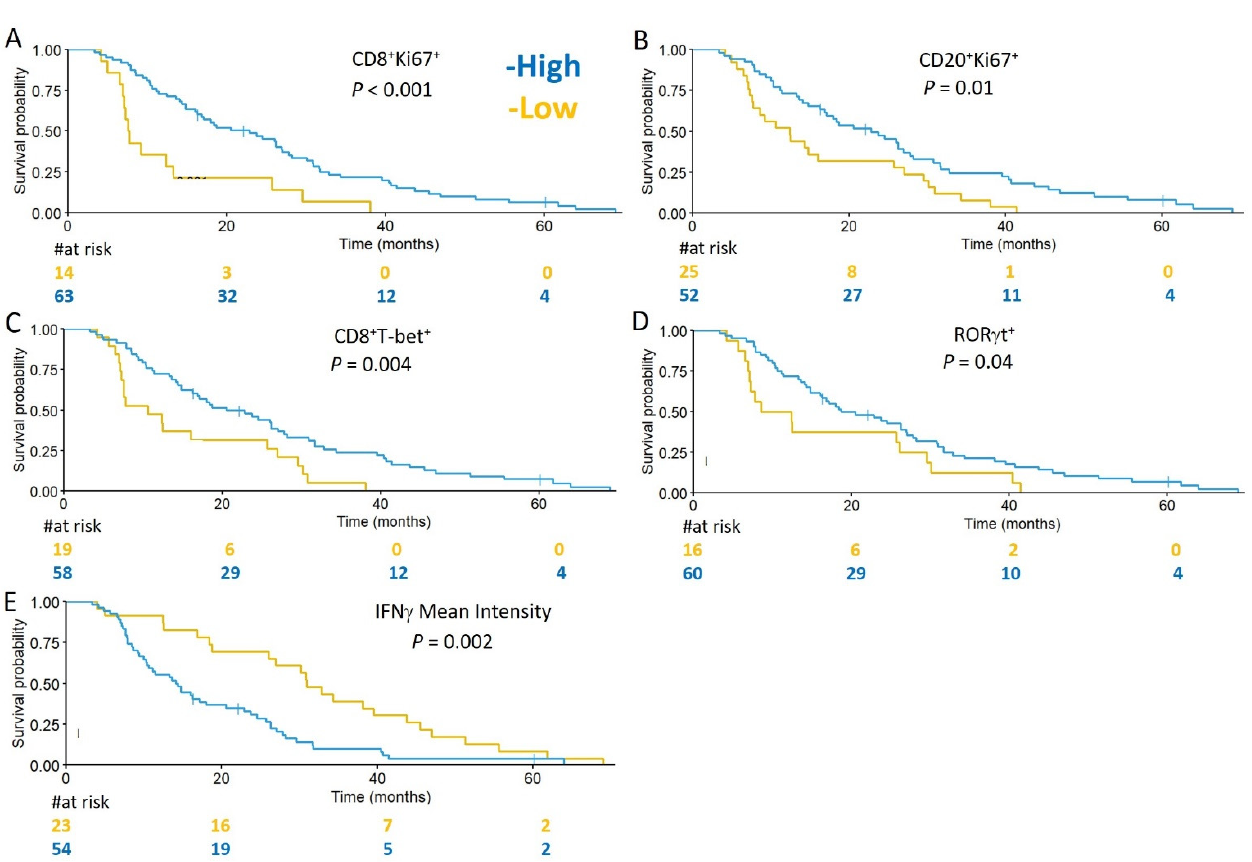
9 of 16 Figure 2. GBM contain focal B and T cell aggregates resembling immature TLS. ( A , B ) Representative images of dense clusters of CD20 + B cells, CD8 + T cells, and PNAd + vasculature from two GBM specimens. The circles denote ROR γ t + cells, scale bars are 100 μ m and colors are indicated. 3.5. Subsets of TIL and Markers of Immune Activity Are Associated with Survival in GBM Patients We hypothesized that specimens containing increased densities of B and T cells ex- pressing markers of proliferation, differentiation, or function, would associate with favor- able prognosis in GBM patients. To assess whether TIL densities and subsets, or markers of immune activity were prognostic for OS, univariate and multivariate Cox proportional hazards analyses were performed. Evaluated immune infiltrates and markers were di- chotomized into high and low categories. In univariate analyses, there was no correlation between total densities of infiltrating CD4, CD8, and CD20 and survival (Table 2). How-